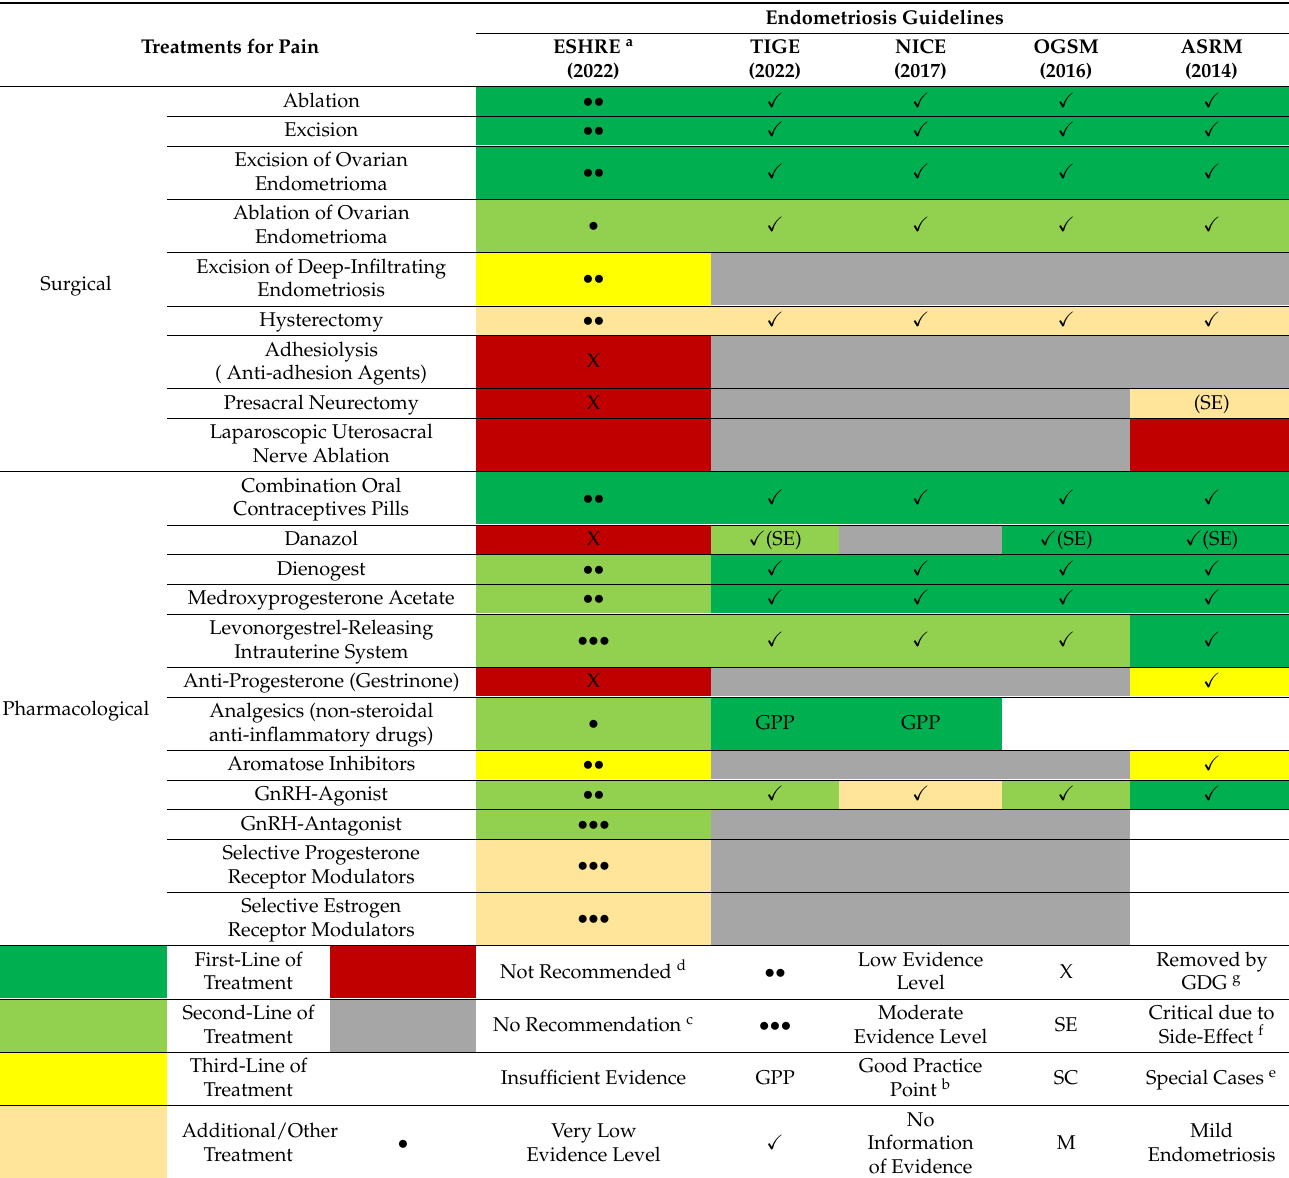
Table 1. Examples of endometriosis guidelines and their level of evidence in treating pain (GPP: good practice points)